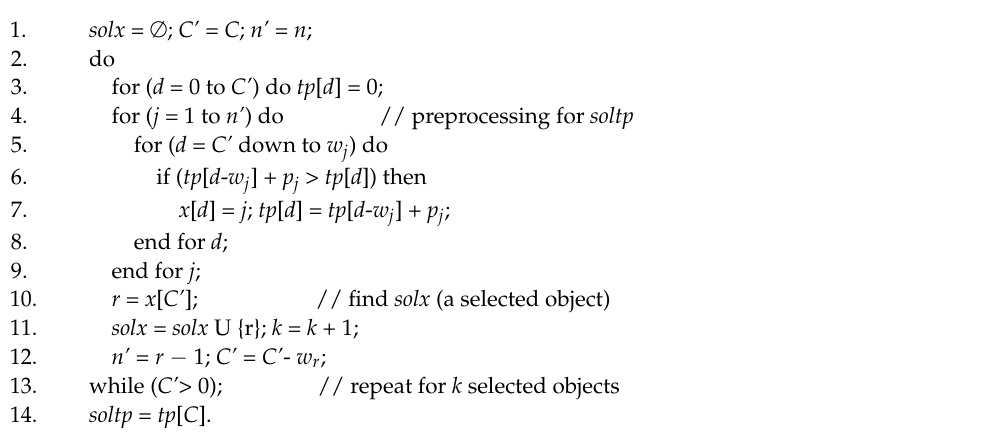
Algorithm 3: Full DP with 1D array (for soltp , soltw , solx [ n ]) in O( knC